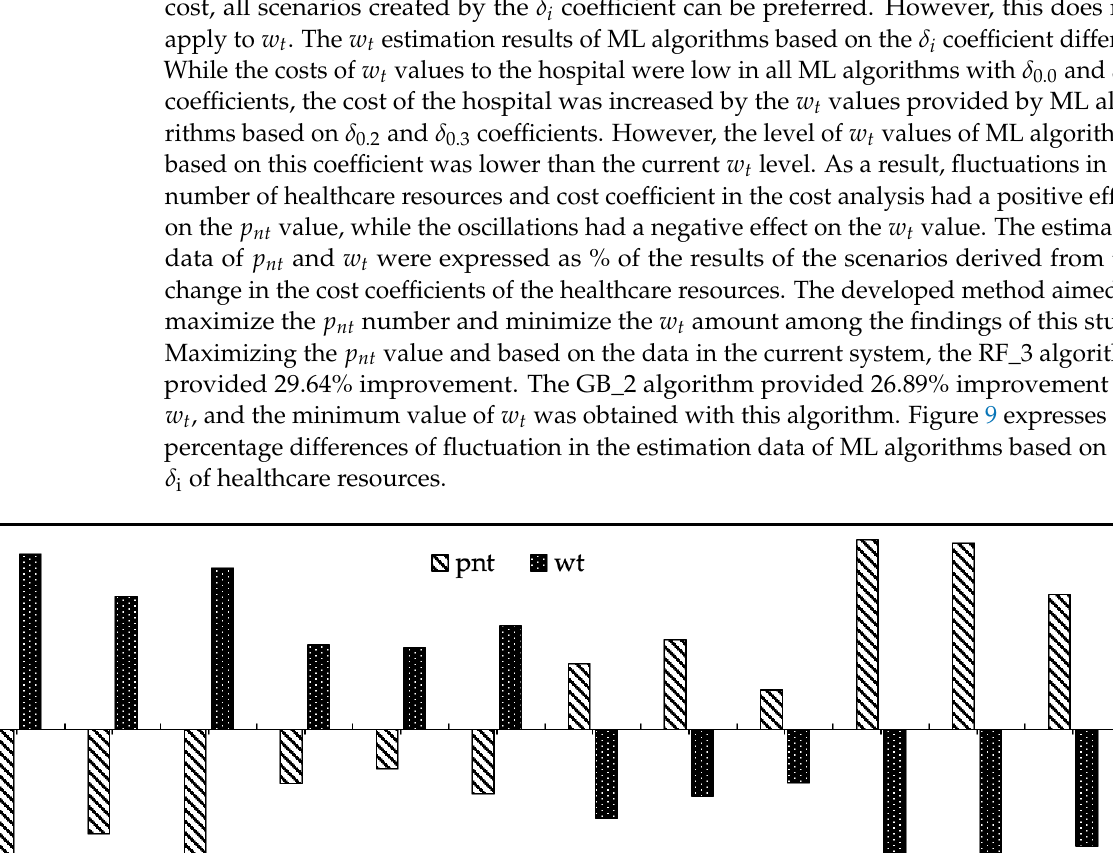
Figure 9. The fluctuation in the forecast data of ML algorithms based on the cost coefficient. In the present research, the average w t of a patient until the completion of all processes related to treatment/examination was calculated as 26.89% based on the GB